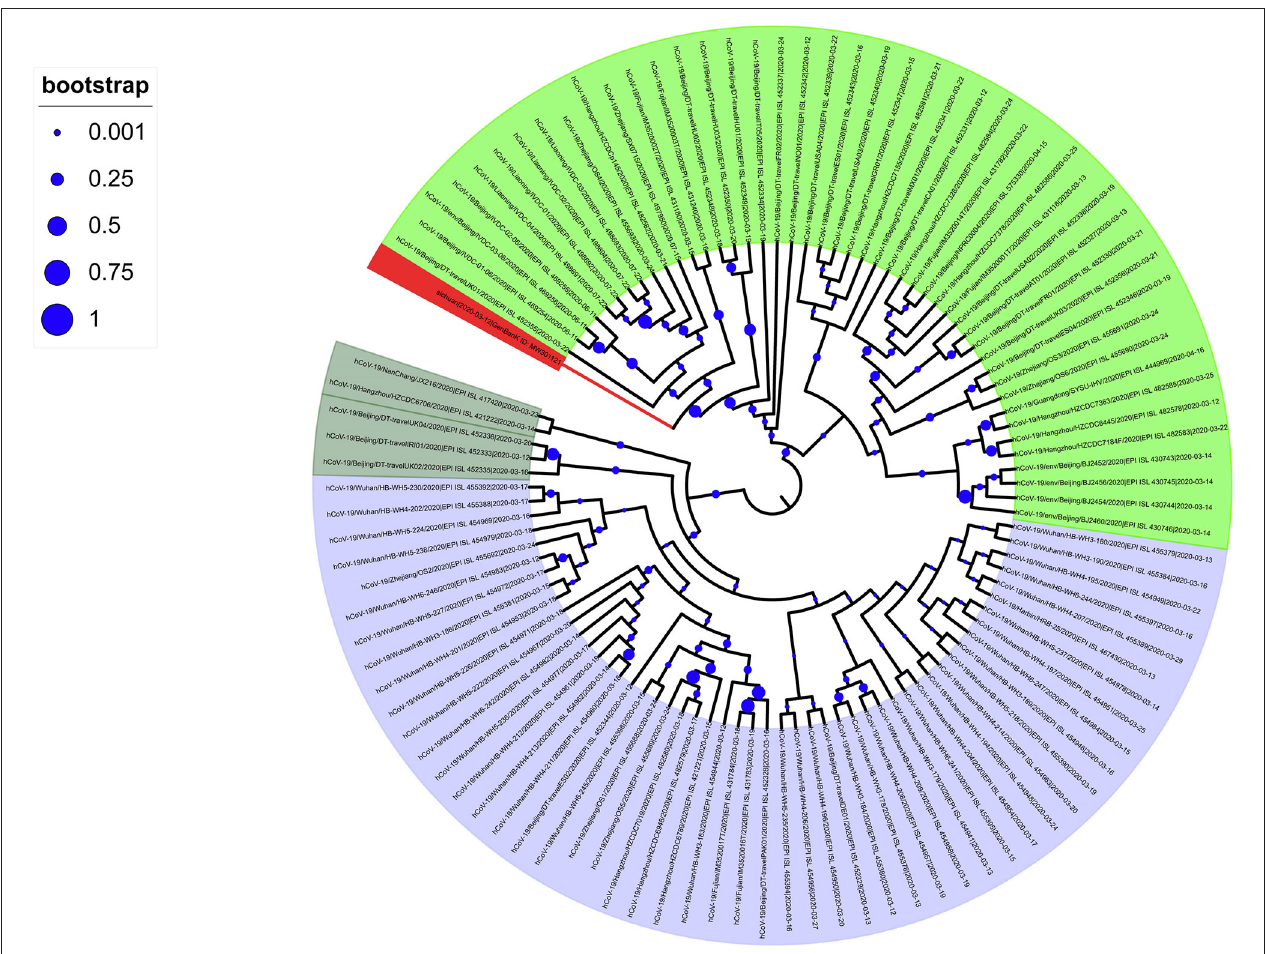
FIGURE 2 | Phylogenetic tree of SARS-CoV-2 sequences collected in China after March 11, 2020. The SARS-CoV-2 of the Wuhan series is Branch A (light blue); the next-generation sequencing sequence (Gene Bank ID: MW301121) was stained